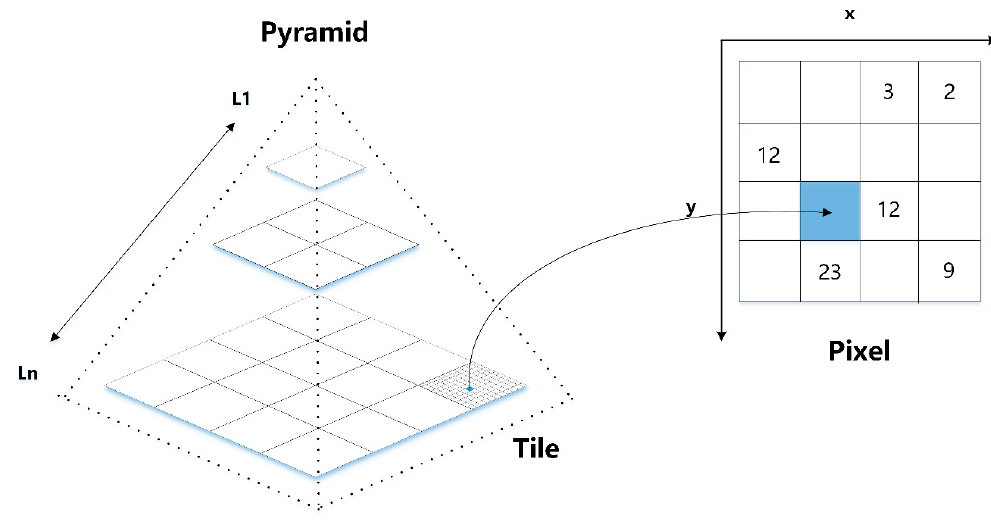
Figure 3. Illustration of the 2D Tile model.